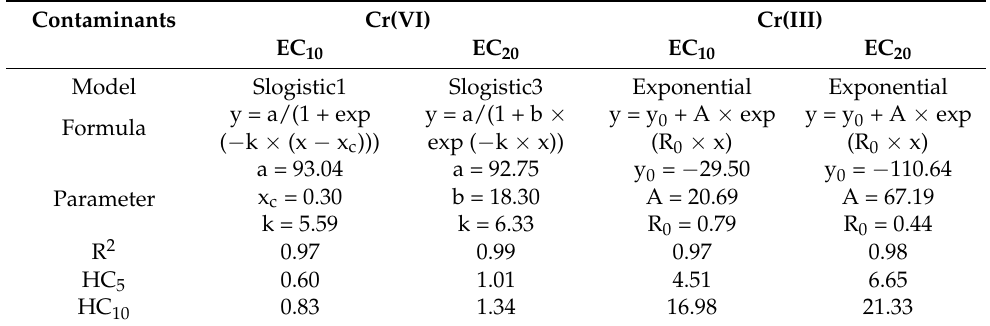
Table 5. The models and parameters of curve fitting and the values of HC 5 and HC 10 for chromium.